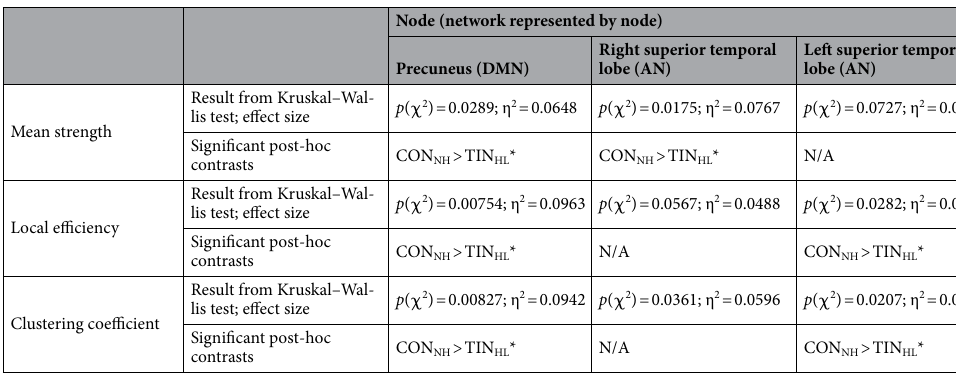
Table 3. Results from Kruskal–Wallis significance tests for tractography metrics. Post-hoc Dunn’s tests were conducted on significant contrasts, with Bonferroni correction. Effect sizes were calculated as η2 based on the H-estimate 66 . DMN default mode network, AN auditory network. * p <